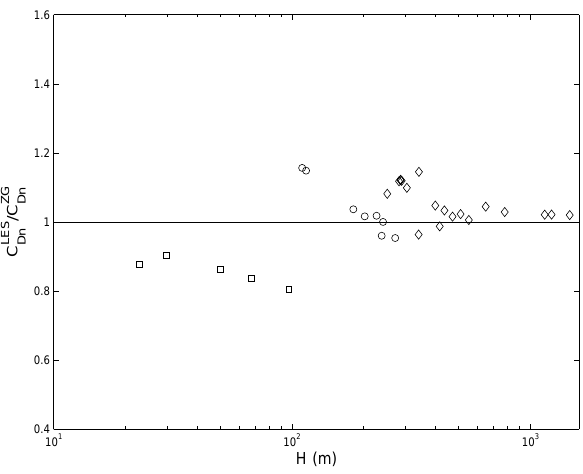
Fig. 13. Significance of the improvements. The curves show /C ZG on the PBL depth H . C Z Dn Dn Dn the ratio between the improved and classical parameterizations. /C Dn ; – – – Panel ( a ) shows theoretical dependences: — C E Dn C H 1 /C Dn ; – · – C H 2 /C Dn . Panel ( b ) shows practical expres- Dn Dn /C Dn ; – – – C G 2 /C Dn ; – · – C Z /C Dn . Param- sions: — C G 1 Dn Dn Dn eters for calculation were U g = 10 m s − 1 , z = 50 m., z 0 = 0 . 1 m., f = 10 − 4 s − 1 . All non-dimensional coefficients were as in